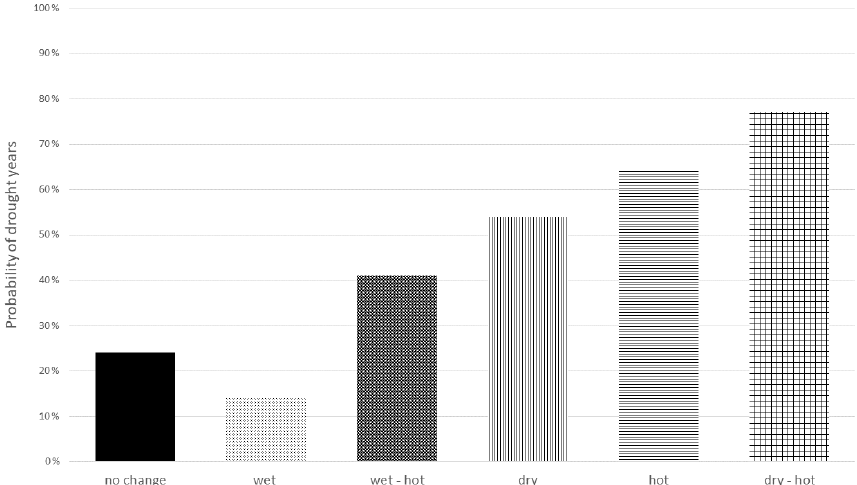
Figure 3. Probability of having a year with 3 or more consecutive months with a standardized precipitation index (SPEI) < − 1, for the climate change